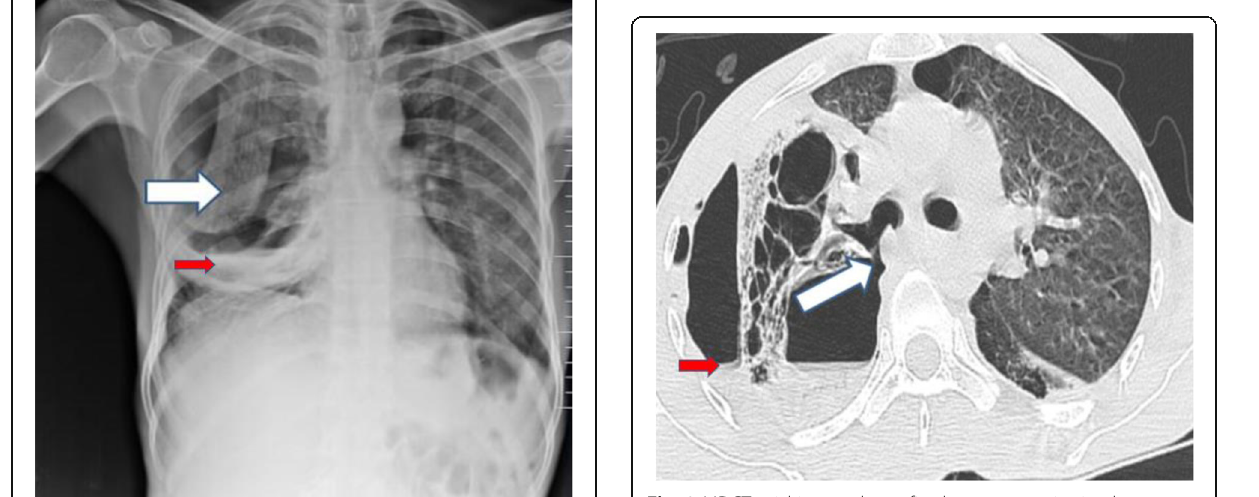
Fig. 2 MDCT axial image shows fistulous communication between right main bronchus and pleural cavity suggestive of central type of bronchopleural fistula (white arrow) with of air fluid level (red arrow) in pleural